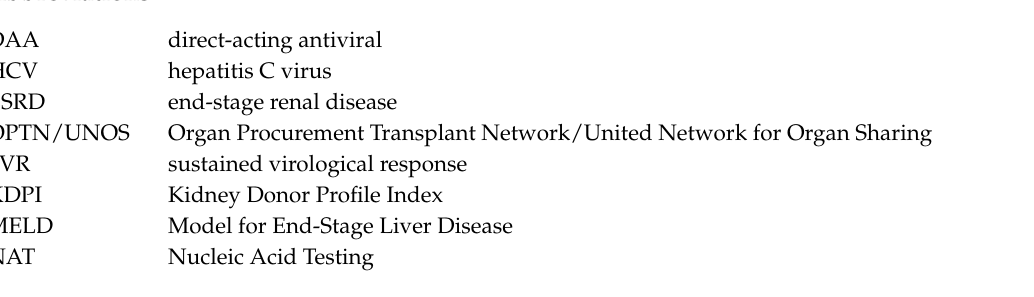
Table S1: Demographics and clinical characteristics of HCV seropositive donors for kidney